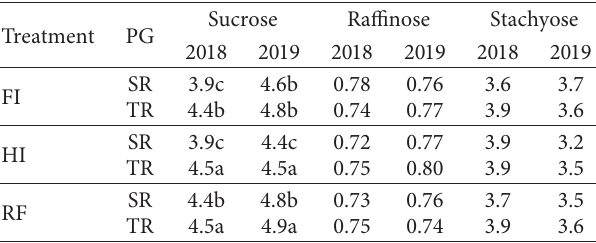
Table 5: Effect of irrigation treatments (FI, HI, and RF) and PG (SR and TR planting) on soybean seed: sugars (sucrose, raffinose, and